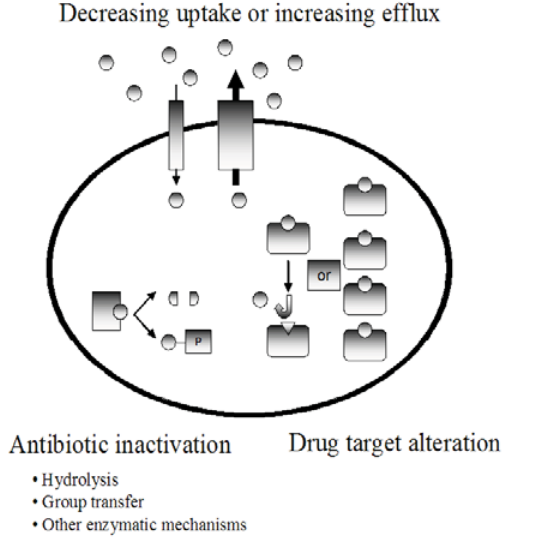
Figure 1. Main mechanisms of active antimicrobial